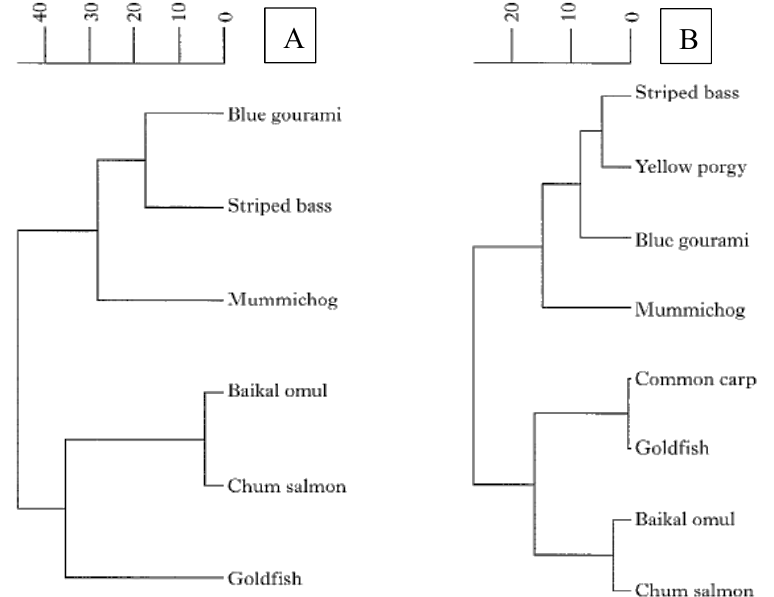
Figure 16. A comparison of the amino acid sequences of FSH- β (gth1) and LH- β (gth2). Identical amino acids are. boxed in black; residues with similar physicochemical properties are boxed in gray [34].